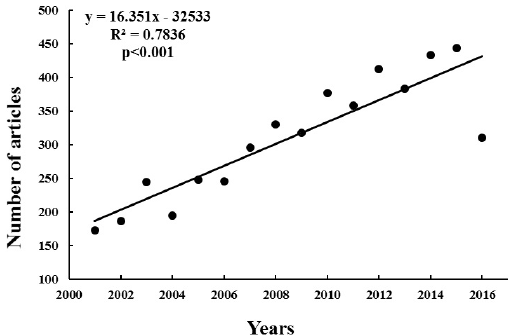
Figure 1. Number of papers published during 2001-2016 in the ISI database.